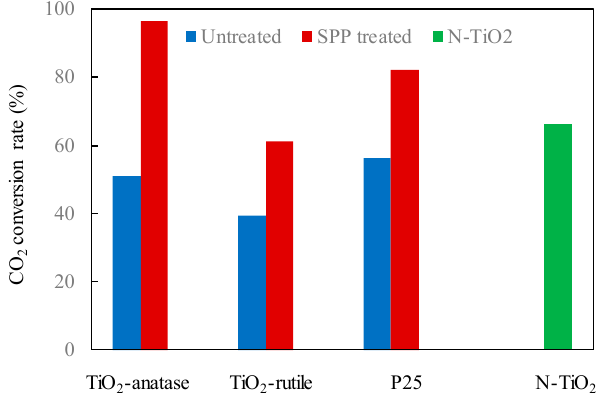
Figure 8. Quantitative comparison of CO 2 conversion rate (%) from the photocatalytic acetaldehyde degradation experiments using different photocatalyst samples [33].